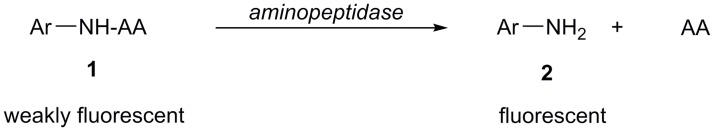
Fluorescence generation from aminopeptidase activity (AA = amino acid).